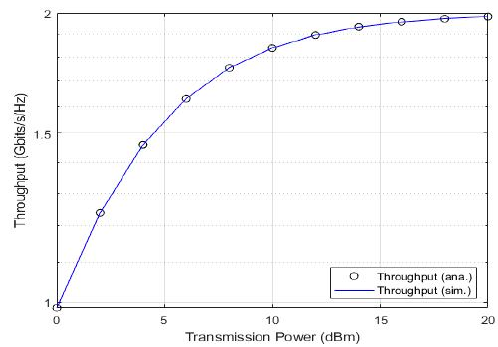
Figure 5. Sum-Throughput vs. Transmit Power.